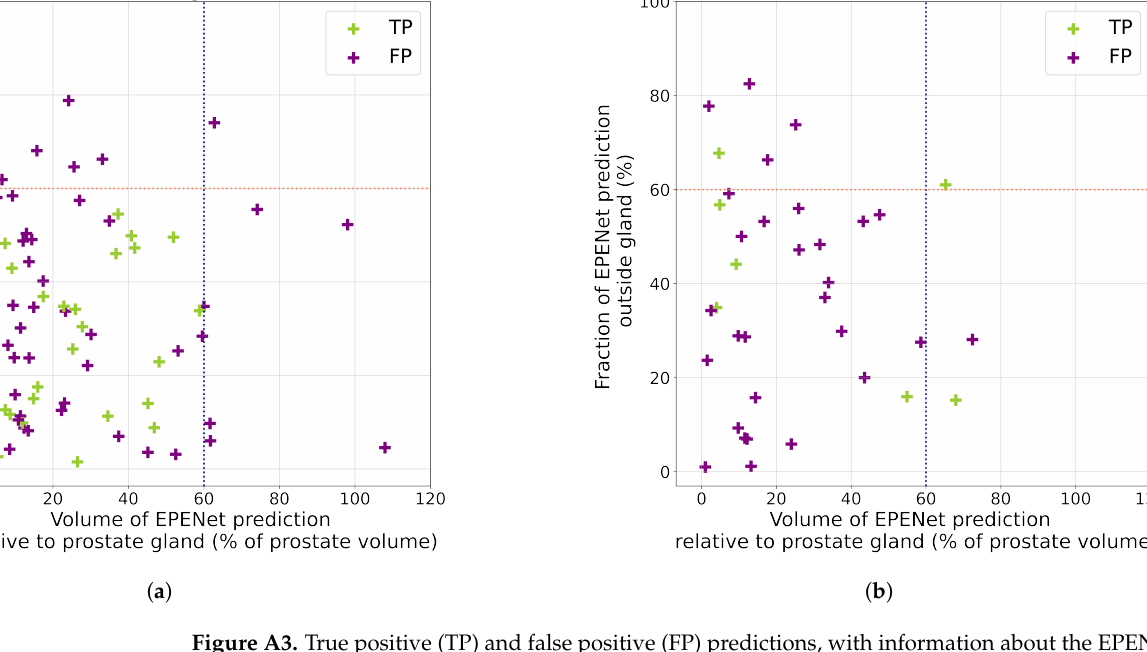
Figure A3. True positive (TP) and false positive (FP) predictions, with information about the EPENet prediction volumes. The x -axis shows the total volume of EPENet prediction as a percentage of the prostate gland volume. The y -axis shows the percentage of the prediction volume that is outside